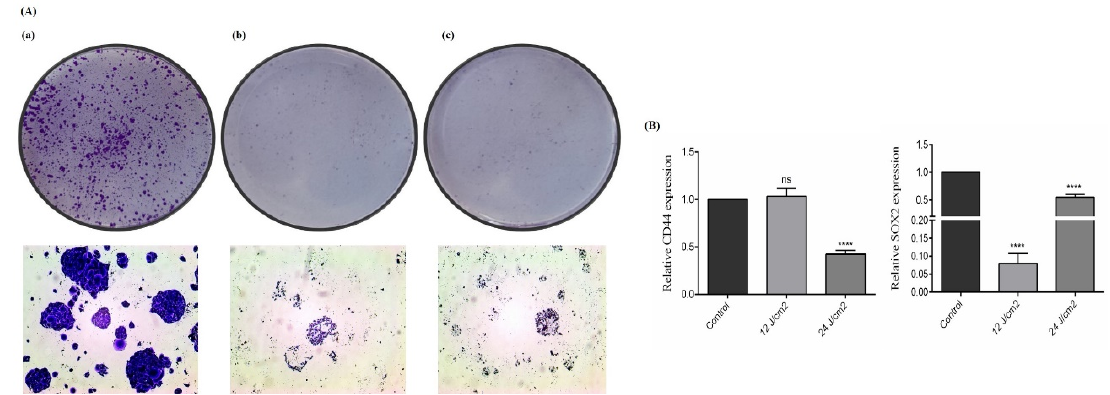
Figure 6. The stemness features of SW480 cells were evaluated after ZnPc-PDT. ( A ) The clonogenicity of tumoral cells was studied 24 h after ZnPc-PDT; ( a ) control cells; ( b ) cells were treated with 12 J/cm 2 and ( c ) cells were treated with 24 J/cm 2 ; ( B ) the effects of ZnPc-PDT on the expression levels of CD44 and SOX2 were studied in SW480 cells at 24 h after ZnPc-PDT; results are means ± SD of three independent investigations and **** p < 0.0001 versus control.